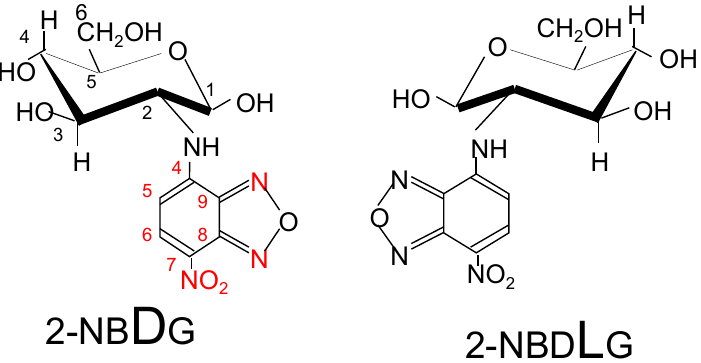
Figure 5. Fluorescent glucose analogs: 2NBDG: 2-[ N -(7-nitrobenz-2-oxa-1,3-diazol-4-yl)amino]-2- deoxy-D-glucose, 2NBDLG: 2-[ N -(7-nitrobenz-2-oxa-1,3-diazol-4-yl)amino]-2-deoxy-L-glucose. Cell–cell glucose relay was suggested to be one of Slc37a4 ′ s roles. Accordingly, it suggested the promotion of glucose uptake as well. The knockdown of Slc37a4 caused a decrease in the uptake rate of 2NBDG, but there was no effect on the uptake rate of 2NBDLG [unpublished data]. Therefore, the up-regulation of Slc37a4 contributed to